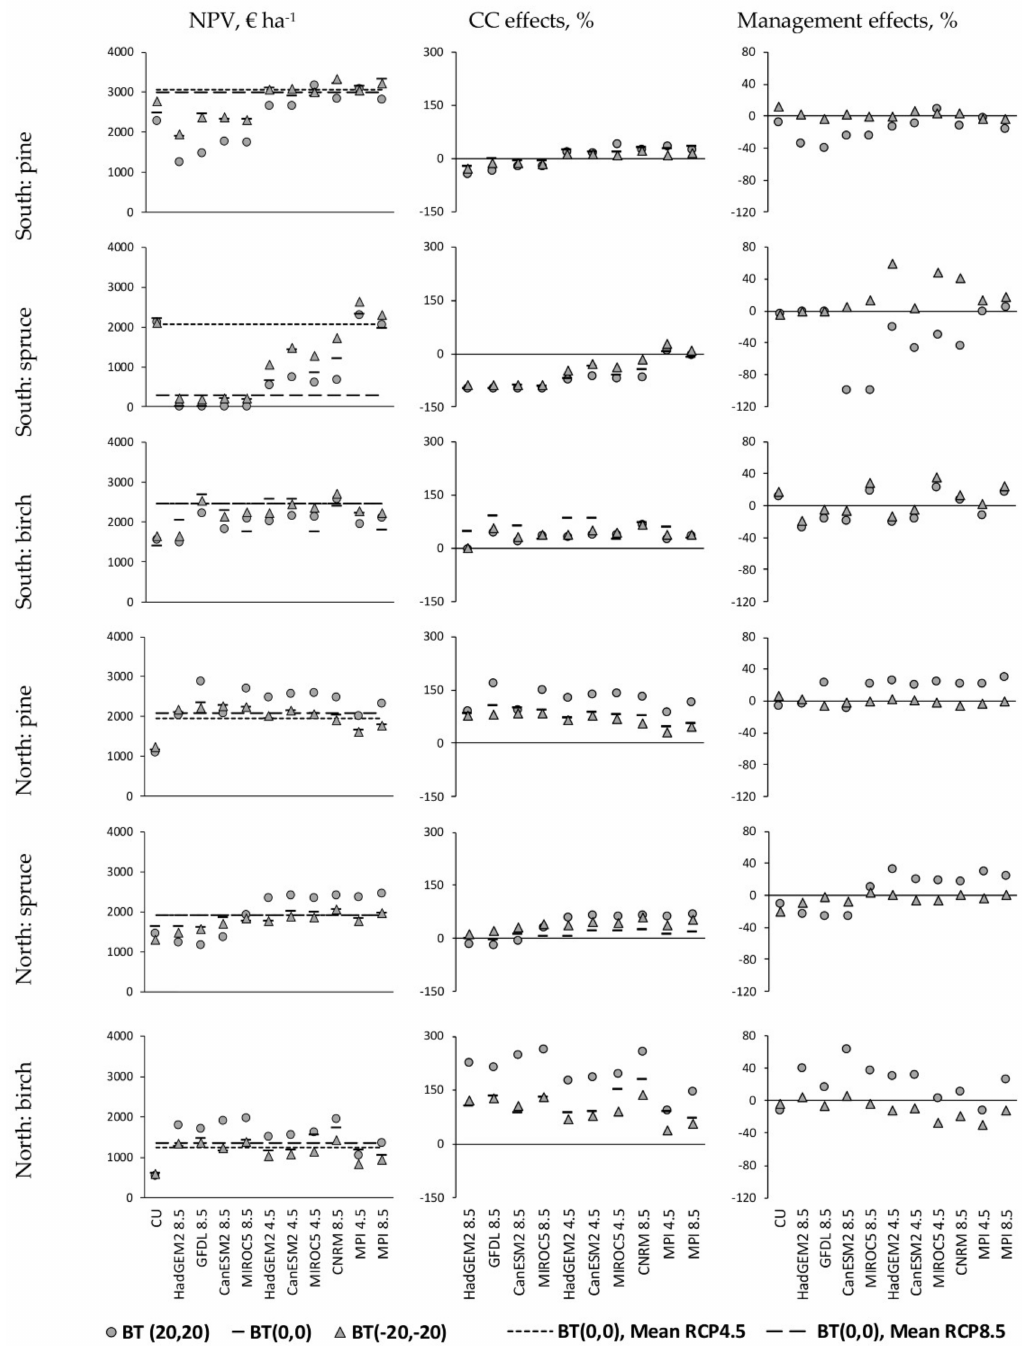
Figure 5. The NPV ( € ha − 1 ) in Scots pine, Norway spruce and birch stands with different management regimes under the current climate (CU) and individual GCM projections (shown in table 2), under the RCP4.5 and RCP8.5 forcing scenarios, in southern and northern Finland. As a comparison, absolute values (on the left) for the multi-model means of the GCM runs under the RCP4.5 (Mean RCP4.5) and RCP8.5 (Mean RCP8.5) forcing scenarios are